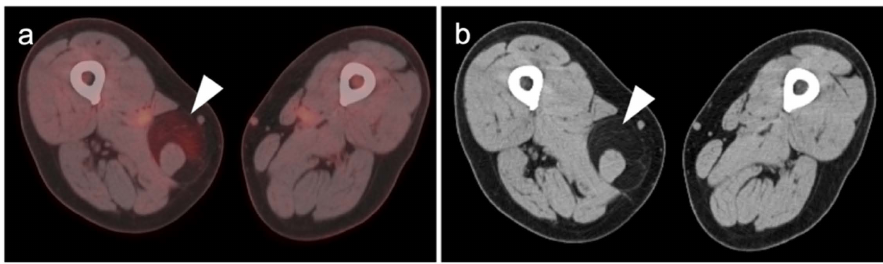
Figure 22. Low-grade liposarcoma. ( a , b ) Axial FDG PET-CT ( a ) and a concurrent axial CT image ( b ) of the thigh show a fatty tumor surrounding the sartorius muscle of the right thigh with a region of increased metabolic activity (white arrowheads) as well as a more posterior region where metabolic activity is low. The patient had pain in the mass, which at biopsy was found to be a low-grade liposarcoma.